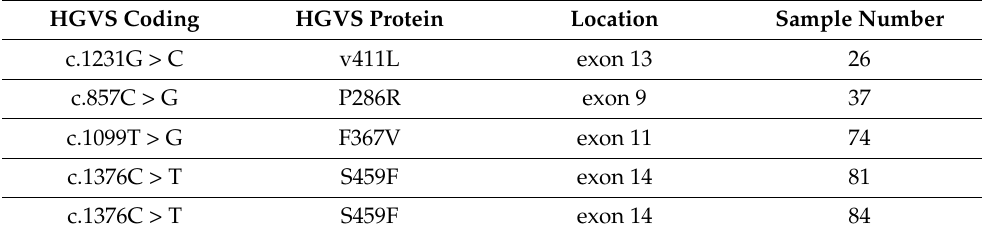
Table 4. Hotspot POLE mutations.